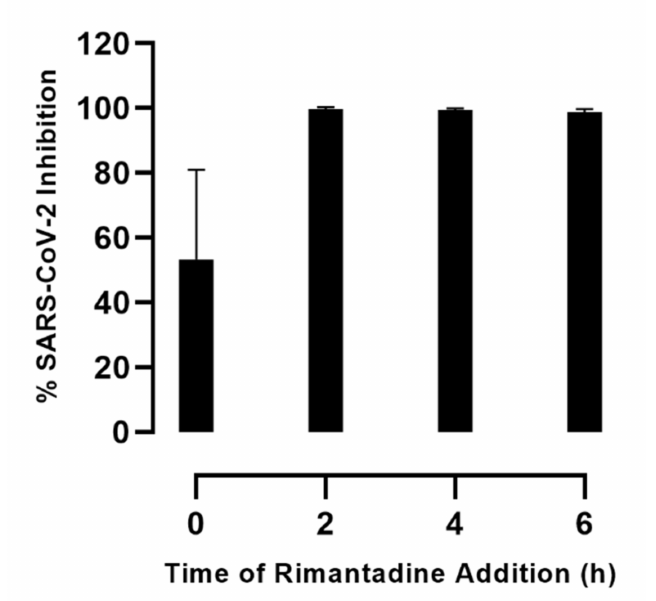
Figure 4. Time-of-rimantadine-addition assay in VeroE6 cells. VeroE6 cells seeded in 96-well plates were inoculated with SARS-CoV-2 during a 2-hour infection phase and treated with 230 µ M rimanta- dine at different timepoints post viral inoculation. At 0 h, viral entry treatment; inhibitor was added together with the virus at 0 h post inoculation and was removed together with the virus following the 2-h infection phase. At 2 h, 4 h or 6 h, post-entry treatment; inhibitor was added 2, 4 or 6 h post inoculation and maintained throughout the 48-hour incubation period. SARS-CoV-2 infected cells were visualized by immunostaining for spike protein and quantified by automated counting. Data- points are means of counts from six replicate cultures ± SEM and represent % inhibition, determined as % SARS-CoV-2 positive cells relative to means of counts from infected-nontreated control cultures, and was calculated as 100%–% residual infectivity. The tested inhibitor concentration did not affect cell viability (Figure